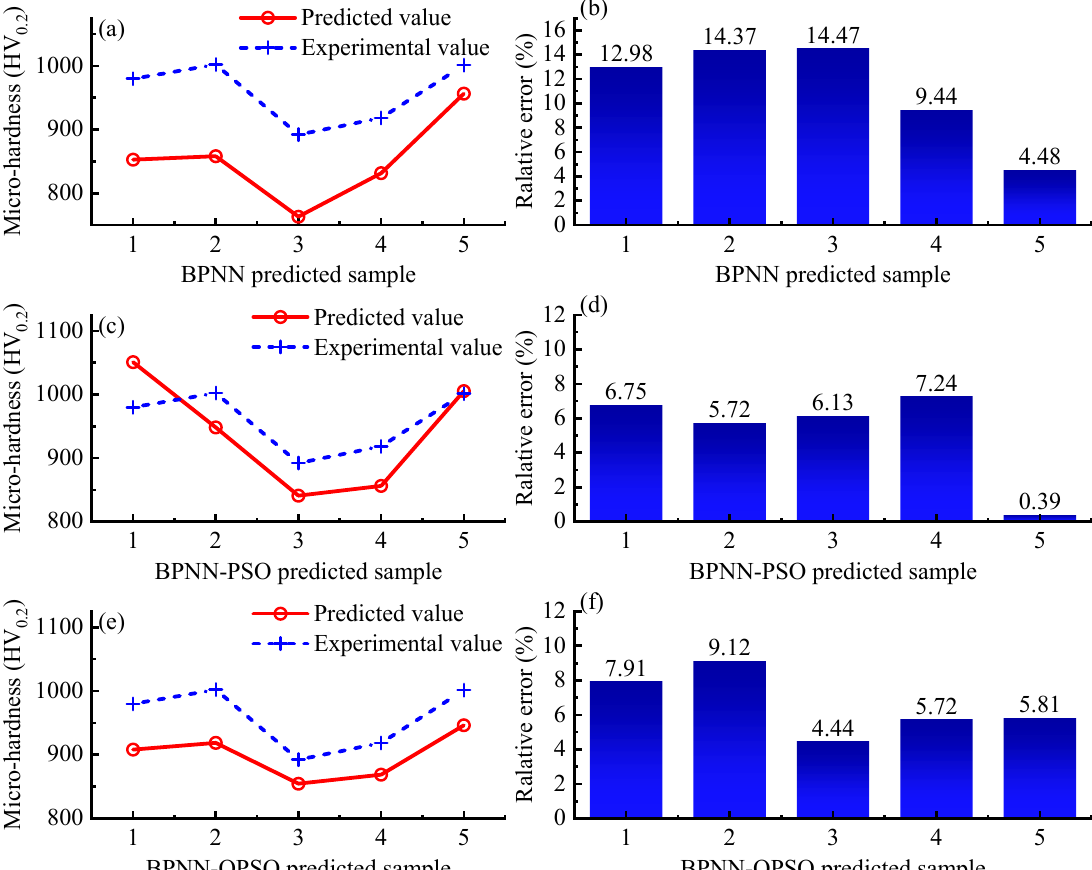
Figure 11. Comparison diagram predicted and experimental micro-hardness of coatings: ( a , b ) BPNN; ( c , d ) BPNN-PSO; ( e , f )